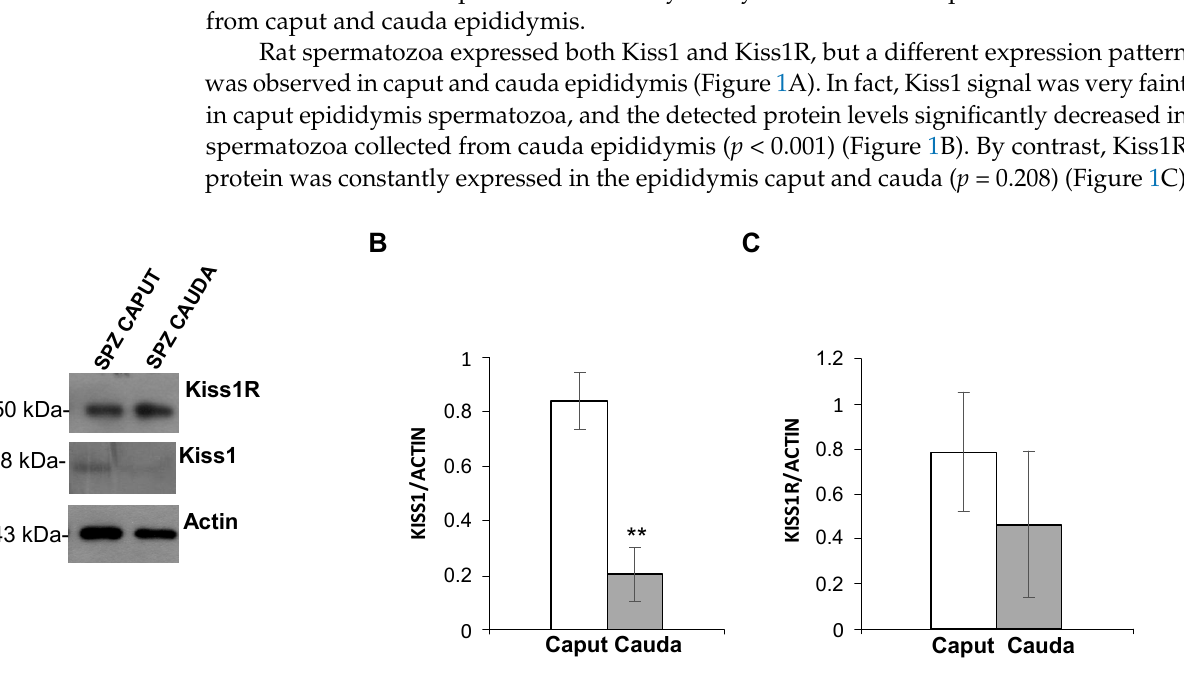
Figure 1. Expression of Kiss1 and Kiss1R in rat spermatozoa collected from epididymis caput and cauda. ( A ) Western blot for Kiss1 and Kiss1R. ( B , C ) Normalizations of Kiss1 precursor, Kiss1, and Kiss1R protein levels carried out against α -Actin. Asterisks indicate statistically significant differences ( p < 0.001, N = 4). Asterisks indicate statistically significant differences ( p < 0.01). Hence, we used immunofluorescence detection to localize Kiss1R within rat spermato- zoa collected from epididymis caput and cauda (Figure